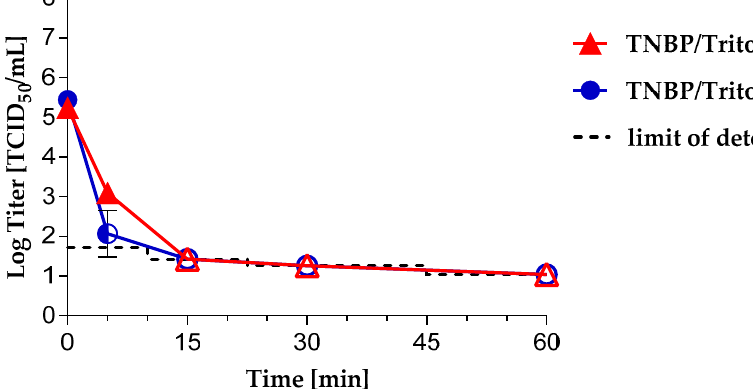
Figure 3. Inactivation kinetics of CHIKV and MAYV under S/D treatment using 0.3% TNBP/1% Triton X-100. CHIKV or MAYV were spiked into 5% albumin solution containing S/D reagents. Experiments were performed in triplicate. Error bars represent the standard deviation. S/D treated samples are indicated by circular (CHIKV) or triangular (MAYV) symbols. Closed symbols = infectivity was detected; open symbols = no residual infectivity was detected; half-open symbol = in 1/3 experiments residual infectivity was detected; the limit of detection depends on the sample volume assayed. Using either TNBP/Tween 80 or TNBP/deoxycholate, CHIKV was completely inactivated after 30 min of S/D treatment (Figure 4).